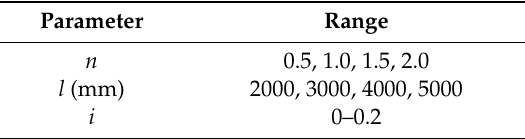
Table 5. Parameter ranges considered in this